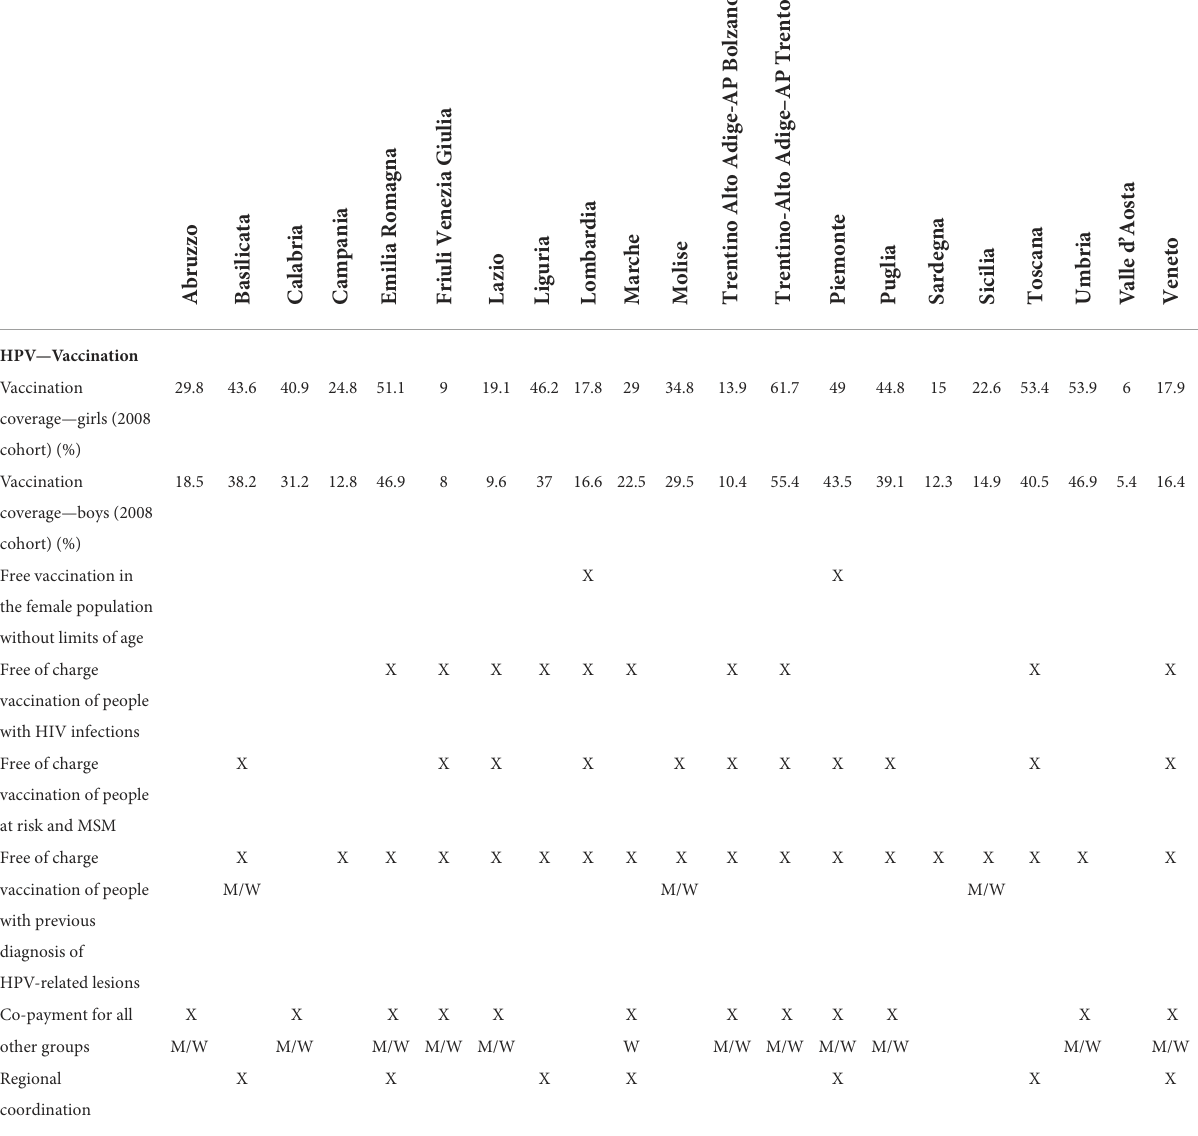
TABLE 2 Summary of information and data on HPV vaccination policies and strategies in the Italian